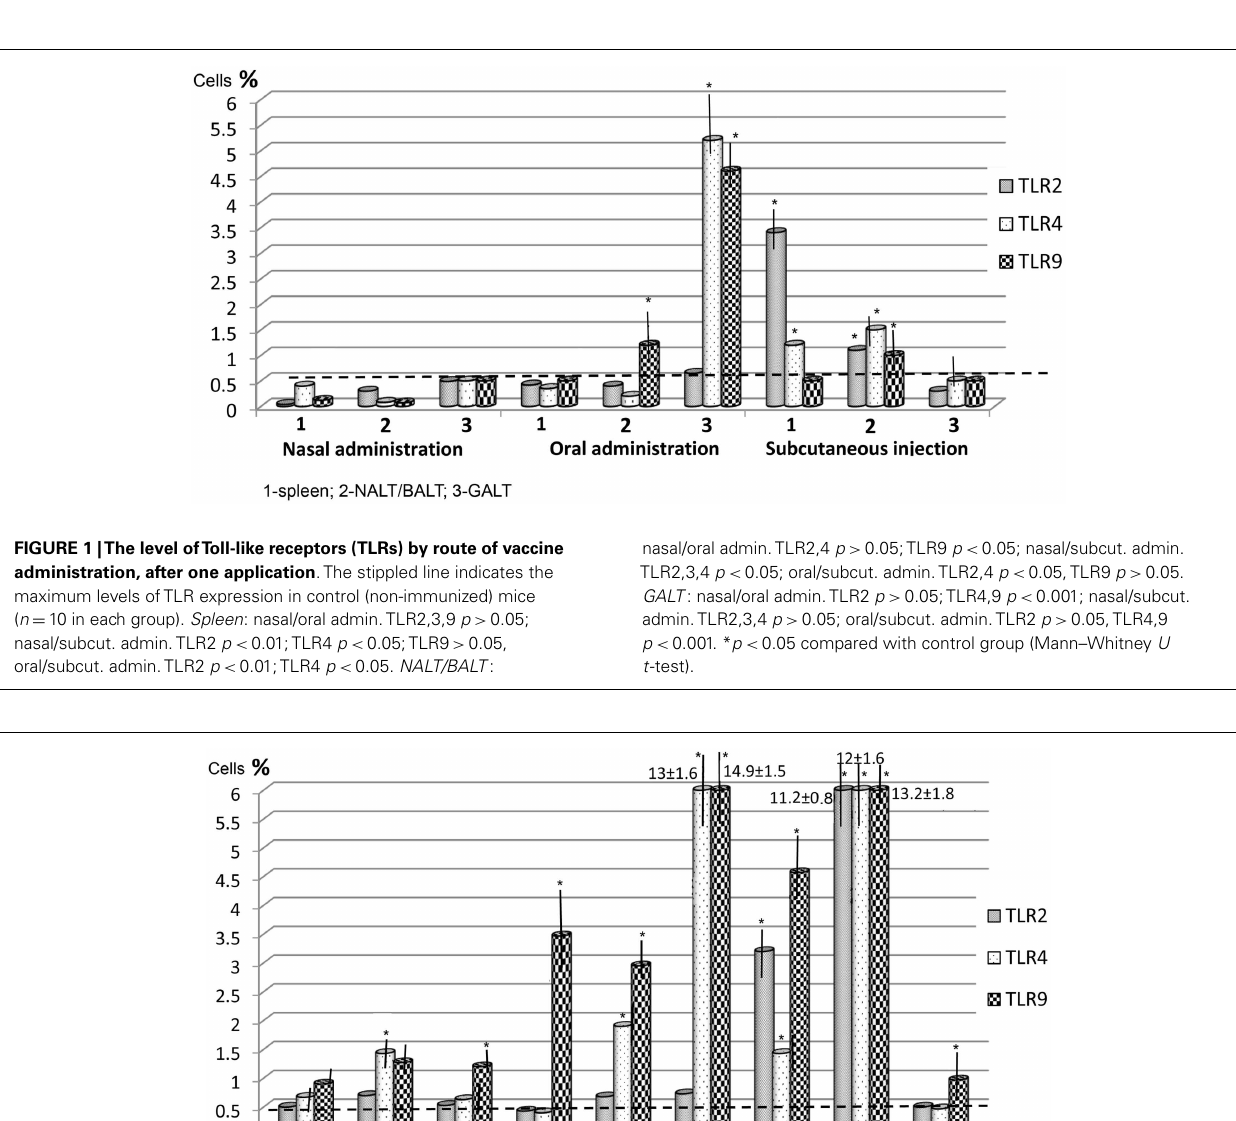
p > 0.05. NALT/BALT : nasal/oral admin.TLR2 p > 0.05;TLR4 p < 0.05;TLR9 p < 0.01; nasal/subcut. admin.TLR2,3,4 p < 0.001; oral/subcut. admin. TLR2,4,9 p < 0.001. GALT : nasal/oral admin.TLR2 p > 0.05;TLR4,9 p < 0.001; nasal/subcut. admin.TLR2,3,4 p > 0.05; oral/subcut. admin.TLR2 p > 0.05, TLR4,9 p < 0.001. * p < 0.05 compared with control group (Mann–Whitney U t